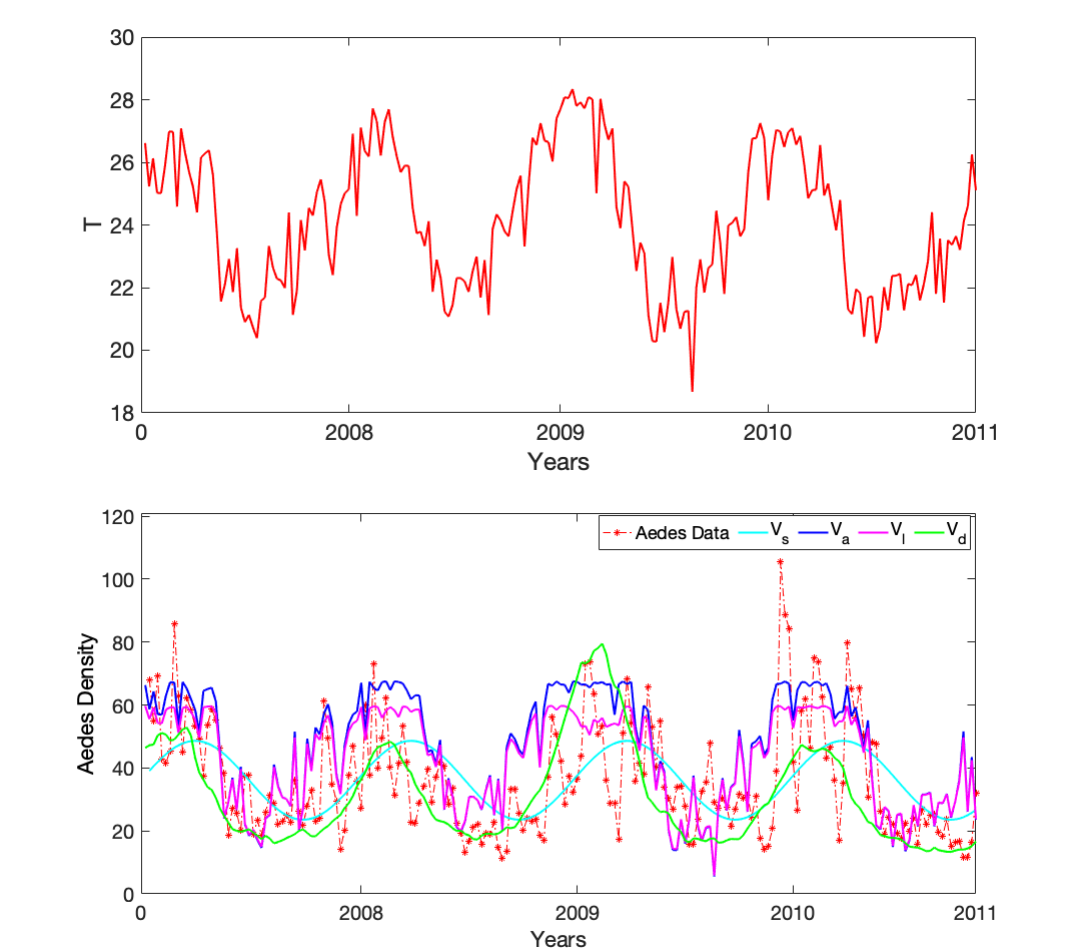
Figure 6. ( Top ) Vitòria city’s weekly average temperature during the period of the study. ( Bottom ) Vitòria city’s Aedes weekly abundance data in red stars and our density estimates evaluated at the weekly temperature in Vitòria city, Brazil. The sine wave density V s in cyan blue, the adult trait-dependent density V a in dark blue, the life stage trait-dependent density V l in magenta, and the dynamical density V d in green. Mosquito and temperature data both from